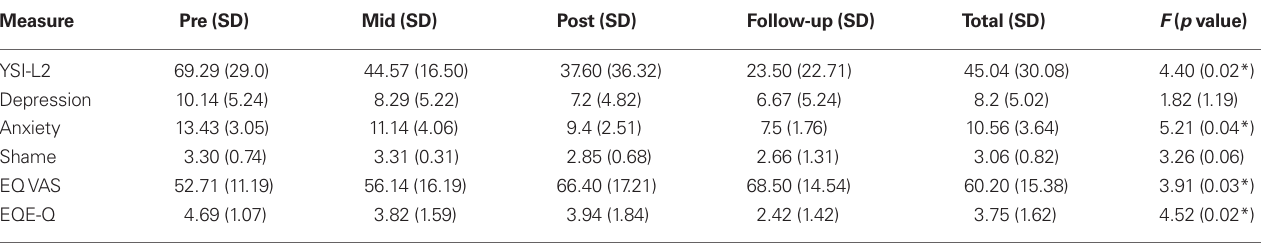
Table 2 | Means, standard deviations, F statistics and the p value of the six questionnaire measures as a result of the repeated measures ANOVA.